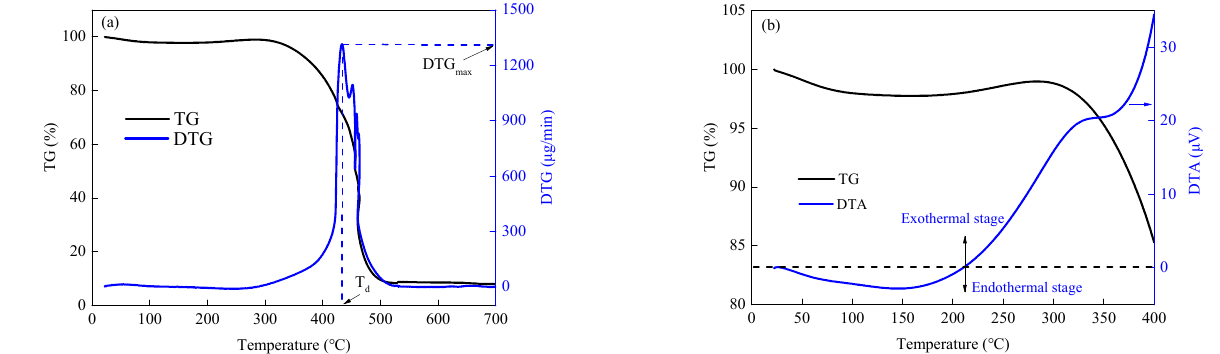
Figure 4. The typical thermogravimetric and derivative thermogravimetric (TG-DTG) curve ( a ) and the di ff erential thermal value (DTA) curve ( b ) of the decomposition of coal dust.